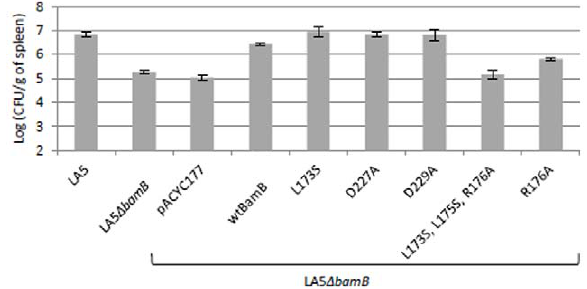
Figure 4. Influence of bamB point mutations on Salmonella virulence in mice. Groups of 10 six-week-old BALB/C mice were orally inoculated with about 5.10 8 CFU of the different S. Enteritidis strains. Spleen colonization was determined at six days post-inoculation. At least two independent experiments were performed for each strain. Results corresponding to the compilation of all experiments are shown. Results were compared by variance analysis followed by a Tukey- Kramer test (Systat 13, Systat software). Significant differences are presented in Table S2.